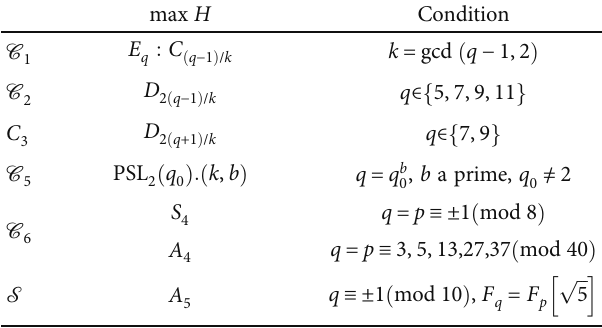
Table 1: PSL ð q Þ , q ≥ 5 (Chap II Theorem 8.27 of [15]). 2 max H